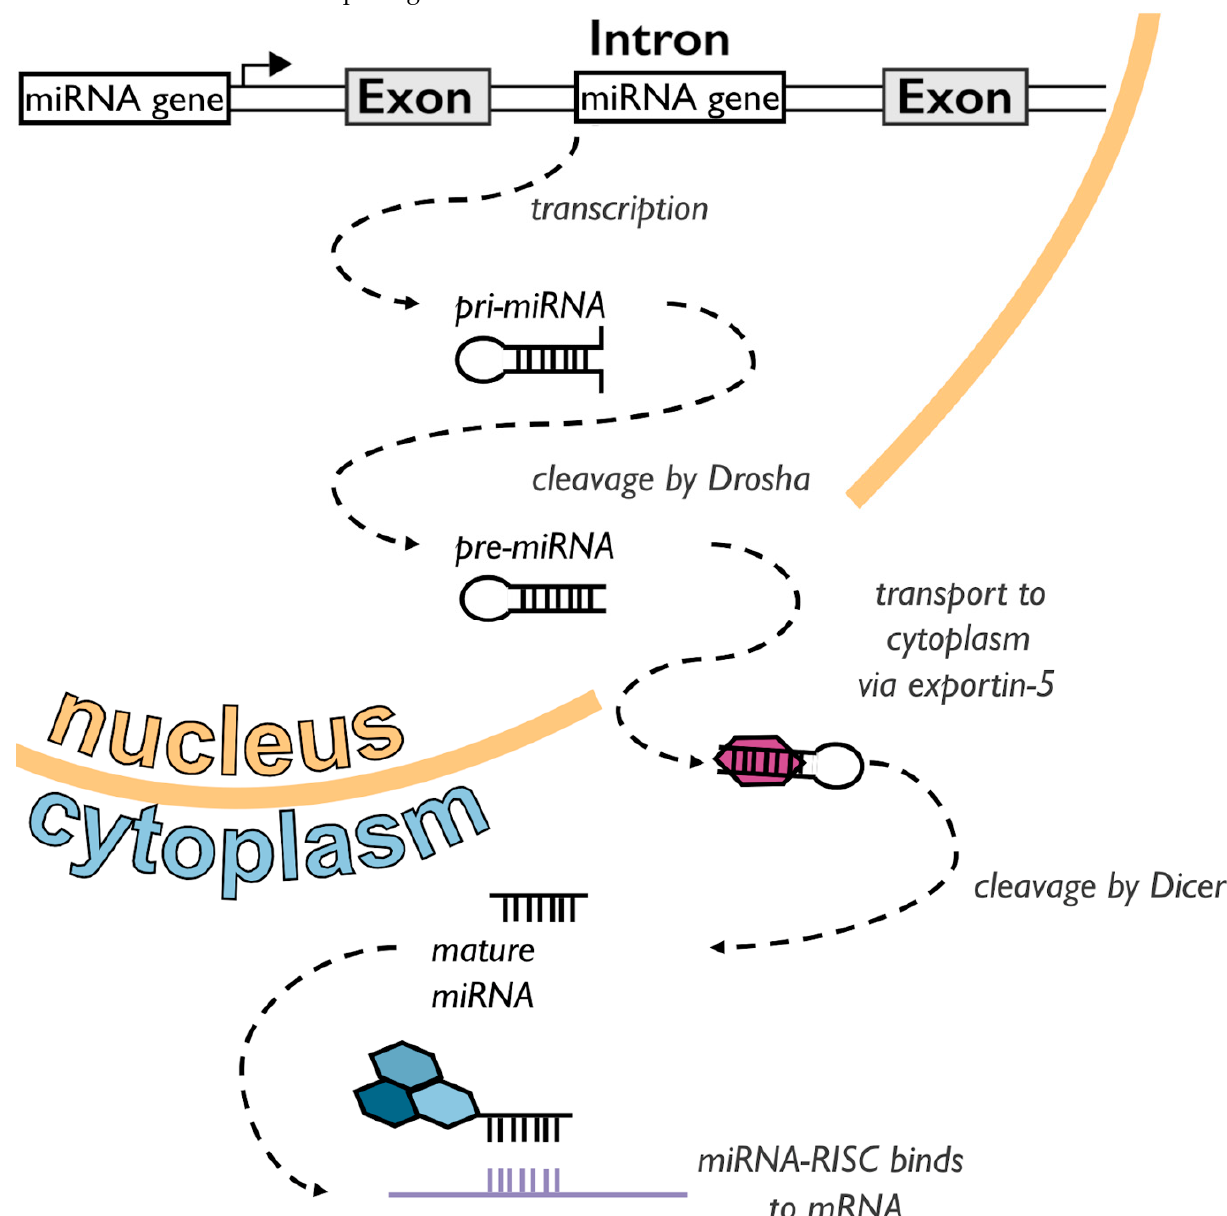
Figure 1. Simplified overview of miRNA synthesis: miRNAs are transcribed from untranslated regions (UTRs) or intronic regions of the genome. The transcribed pri-miRNA is cleaved by the enzyme Drosha into the pre-miRNA form, which is then transported through the nuclear pore complex to the cytoplasm via the enzyme exportin-5. The enzyme Dicer cleaves the pre-miRNA into its mature form, where it can start regulating mRNA following binding to the RISC complex.